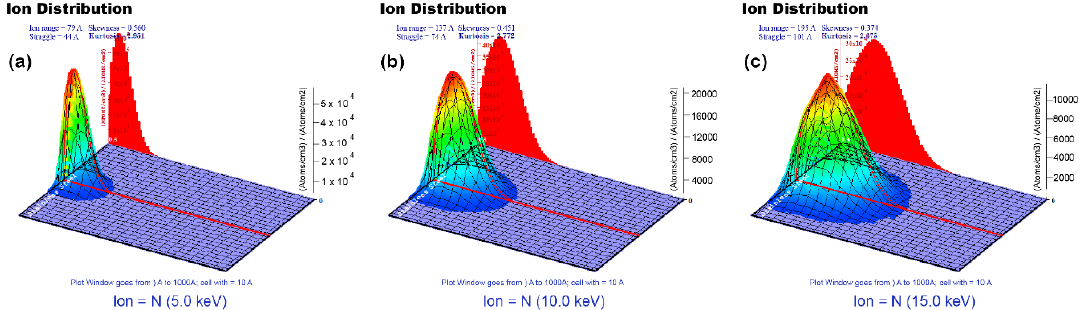
Figure 2. Monte Carlo simulation program (TRIM) simulations for nitrogen profiles of implanted samples: ( a ) 5 kV, ( b ) 10 kV, ( c ) 15 kV.